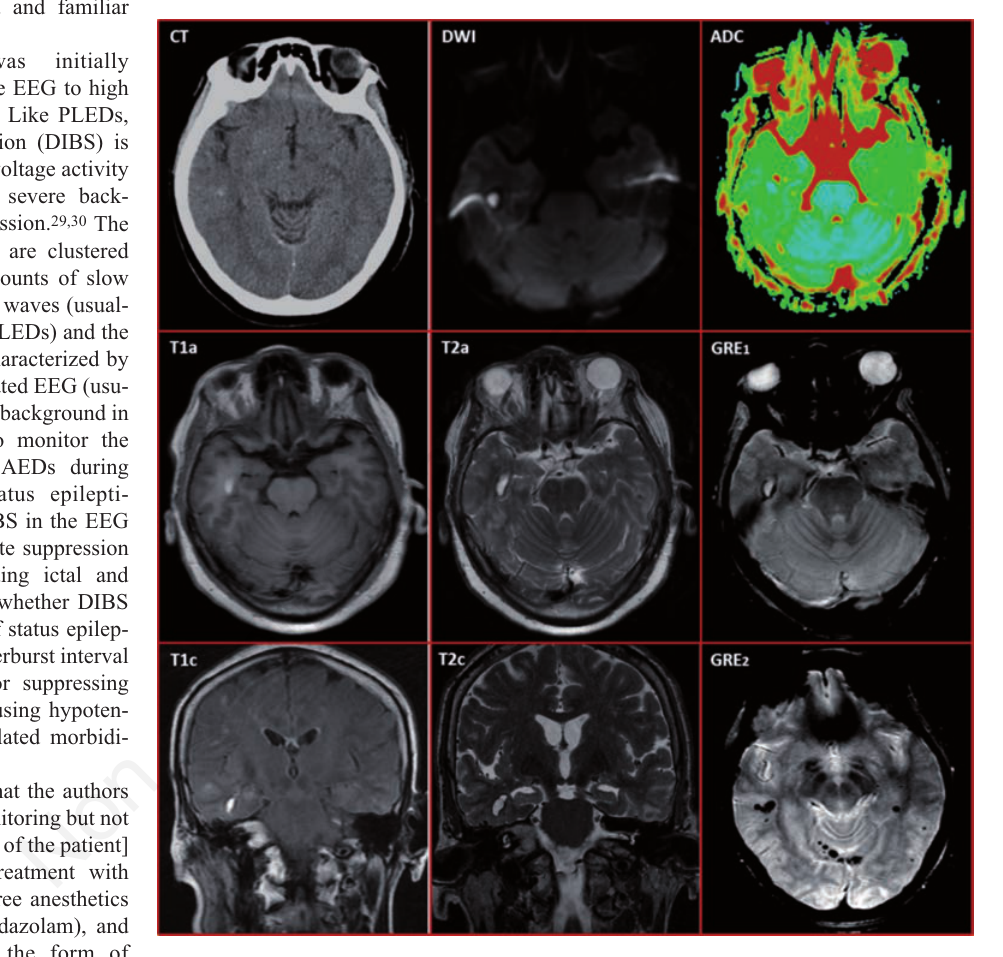
Figure 1. Brain structural imaging showing a circumscribed lesion in the inferior aspect of the right temporal lobe. Non-contrast CT (CT) shows a punctate hyperintensity in the right temporal area suggestive of calcification. The magnetic resonance imaging (MRI) signal characteristics of the lesion are consistent with a cavernous malformation or cav- ernoma with late subacute hemorrhage (core) and old chronic hemorrhage (rim) corre- sponding to a type I cavernoma in the MRI-based classification of Zabramski et al.35 The lesion is hyperintense (bright) on diffusion-weighted imaging (DWI) with high apparent diffusion coefficient (ADC) in the core and low ADC in a portion of the rim. The core is hyperintense on T1-weighted (T1a, T1c) and T2-weighted (T2a, T2c) images, indicating extracellular methemoglobin deposits from late subacute hemorrhage (age of 1 to 4 weeks). The rim is isointense on T1a, slightly hypointense on T1c, and moderately hypointense on T2-weighted sequences. On gradient echo sequences (GRE1), the bright lesion core is surrounded by a very dark rim (blooming artifact), indicating peripheral deposits of hemosiderin (a paramagnetic compound) from an old hemorrhage (age>1 month). Peripheral calcium deposits may also account for some of the blooming since hyperintensity was present on CT (see above). GRE sequences (GRE2) also revealed addi- tional lesions with hypointense (dark) spots in other brain locations, which may repre- sent multiple asymptomatic hemorrhages in the past, perhaps from other